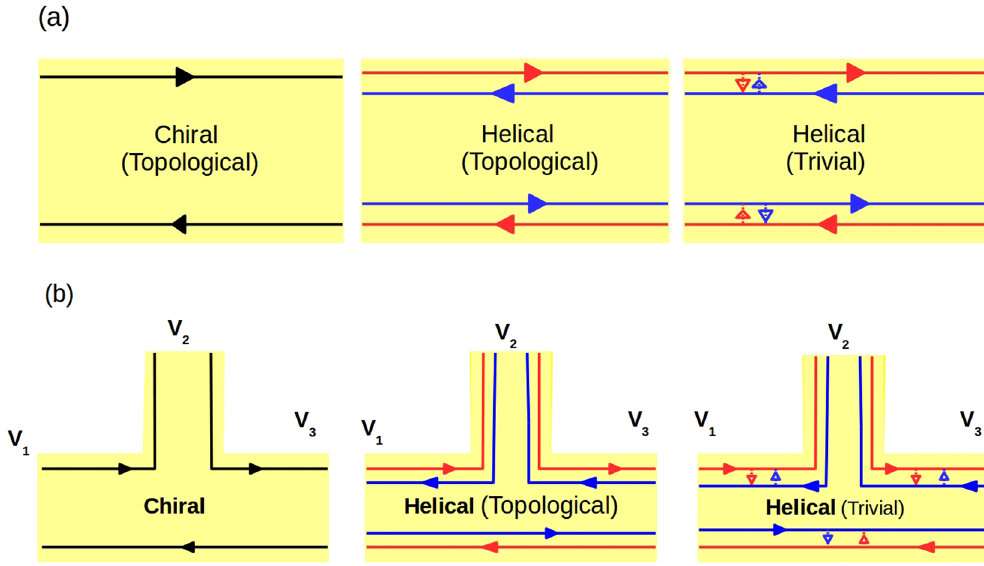
Figure 1. ( a ) Chiral vs Helical (Topological) vs quasi-Helical (Trivial), ( b ) 3-terminal QH, QSH(topological) and QSH(trivial)